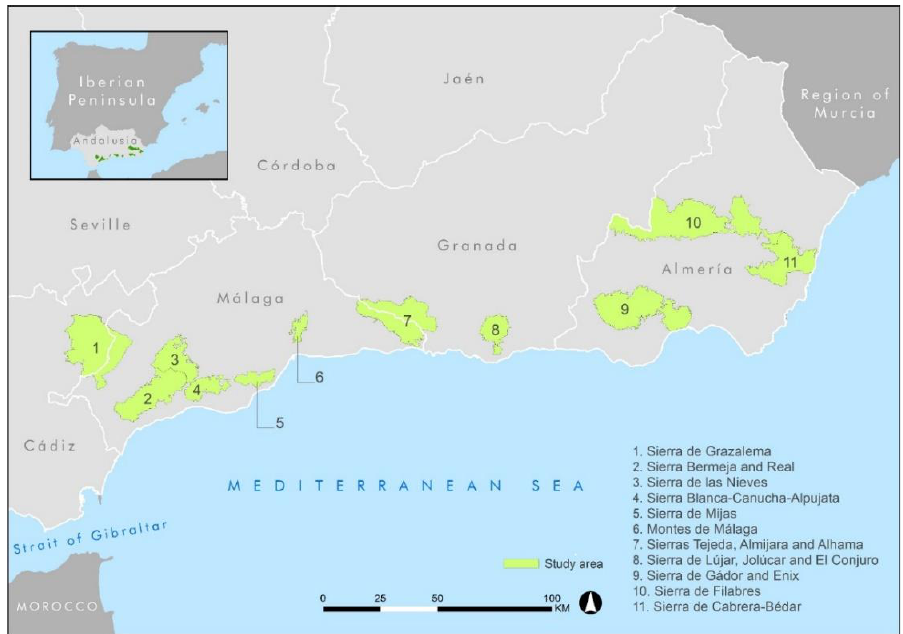
Figure 1. Location of the study area and selected natural areas. Own elaboration based on Basic Spatial Data of Andalusia (DERA). Statistical and Cartographic Institute of Andalusia. Government of Andalusia. Table 1. Surface and high values of the natural areas.